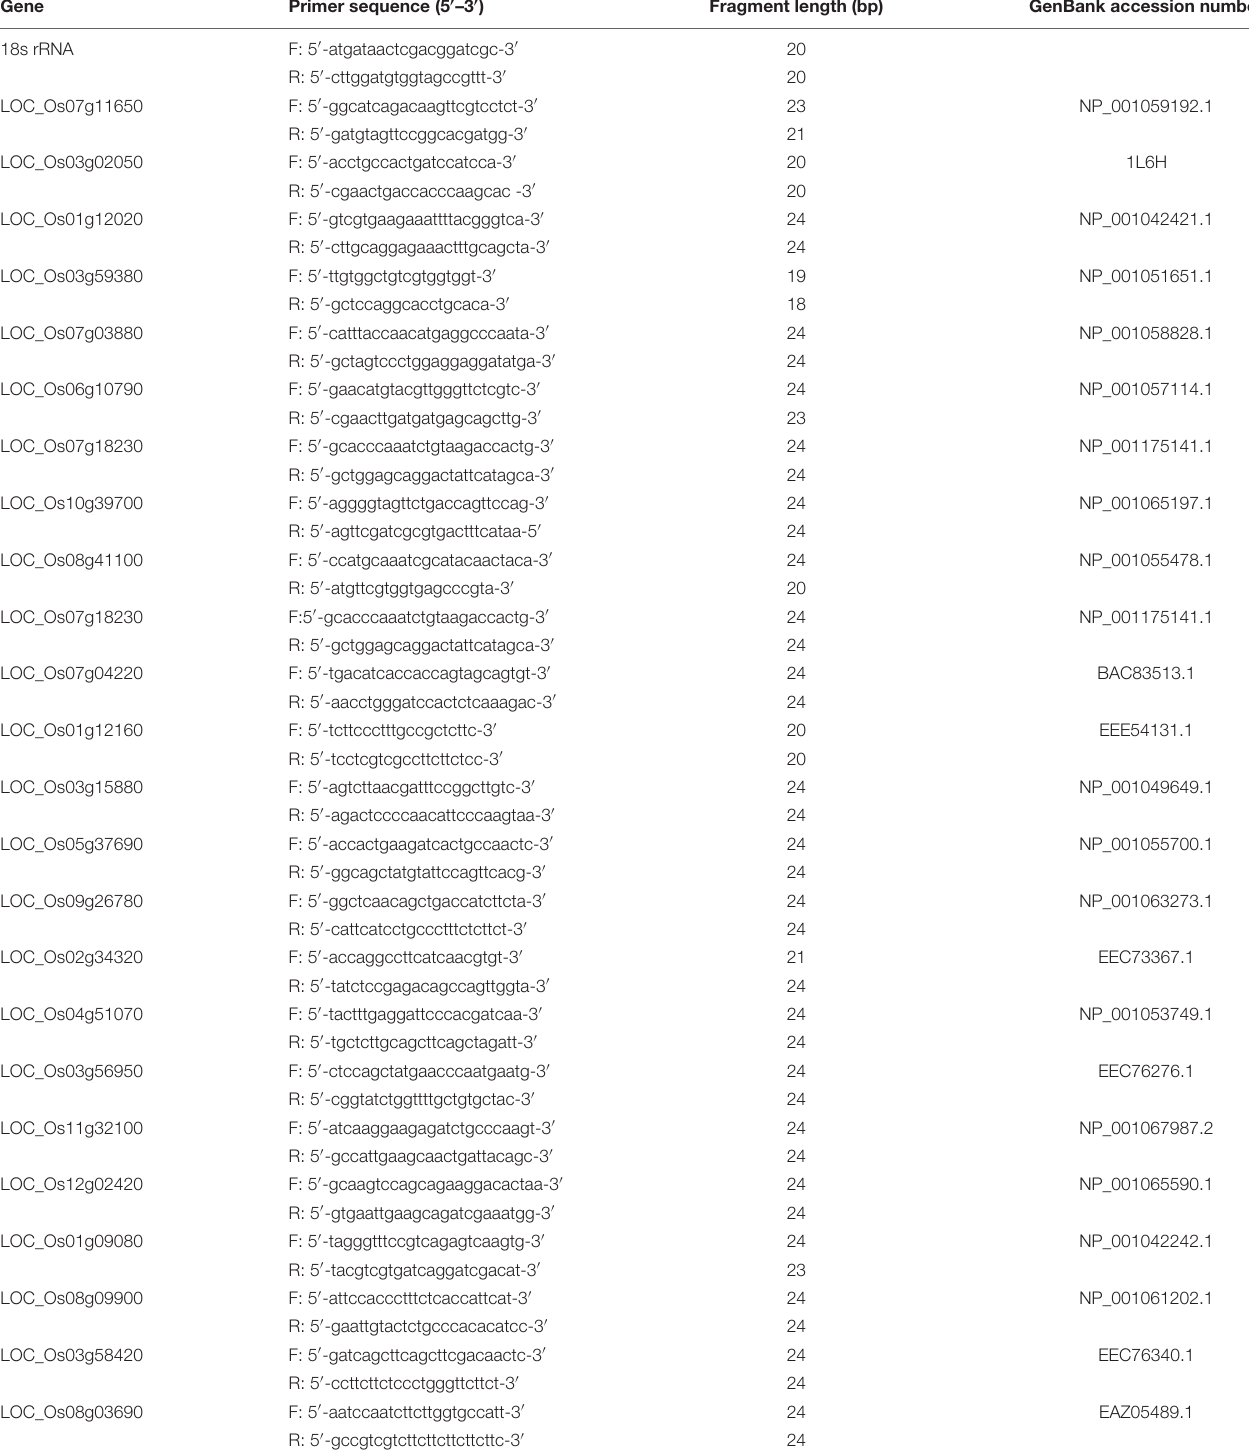
TABLE 2 | Sequences of